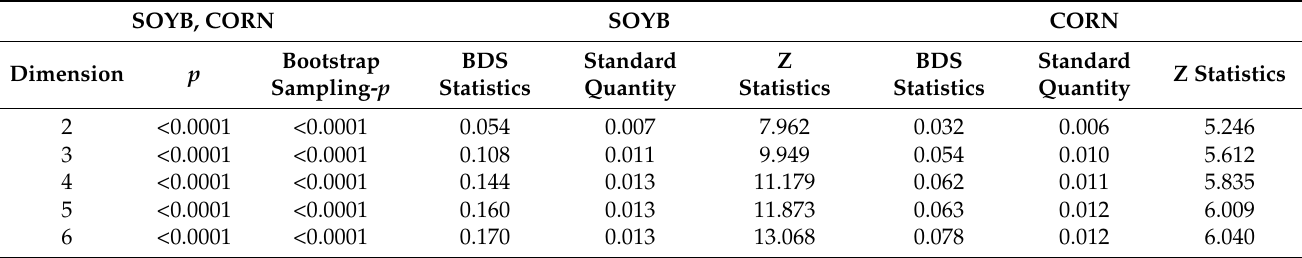
Table 2. Nonlinear test results.